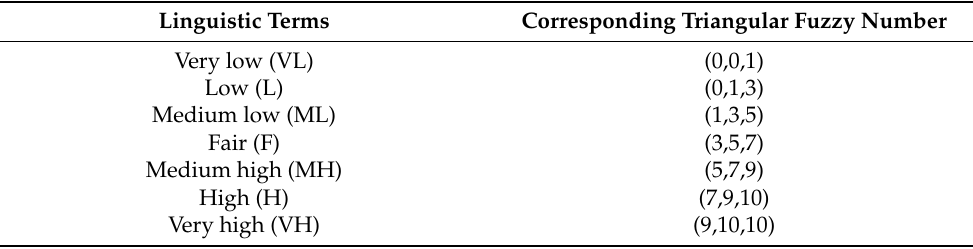
Table 6. Transformation rules of linguistic variables of decision makers to fuzzy numbers for criteria performance of planning alternatives.